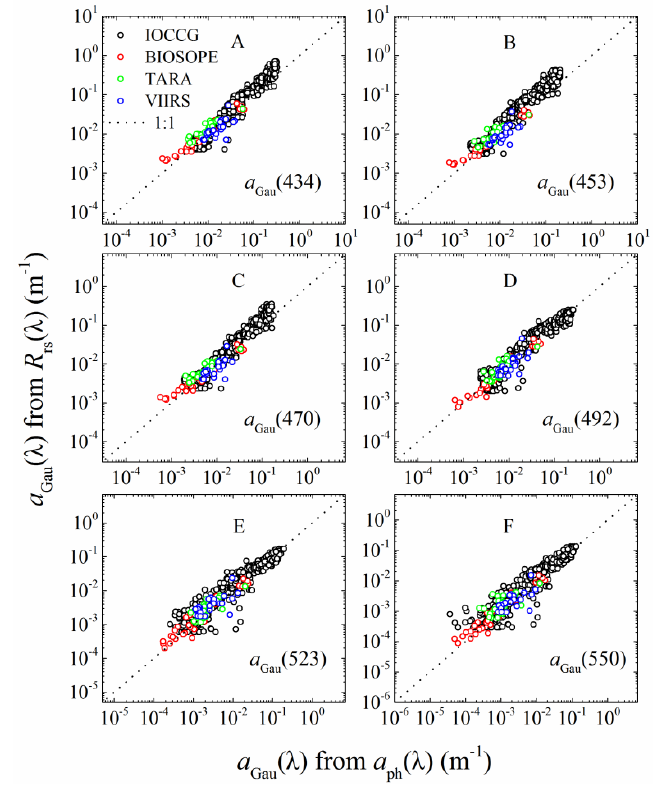
Figure 3. a Gau (λ) heights retrieved from R rs (λ) at MEdium Resolution Imaging Spectrometer (MERIS) Figure 3. a Gau ( λ ) heights retrieved from R rs ( λ ) at MEdium Resolution Imaging Spectrometer (MERIS) bands versus measured Gaussian peak (decomposed from a ph (λ)) for the data from different datasets bands versus measured Gaussian peak (decomposed from a ph ( λ )) for the data from different datasets (shown in different colors). (shown in different